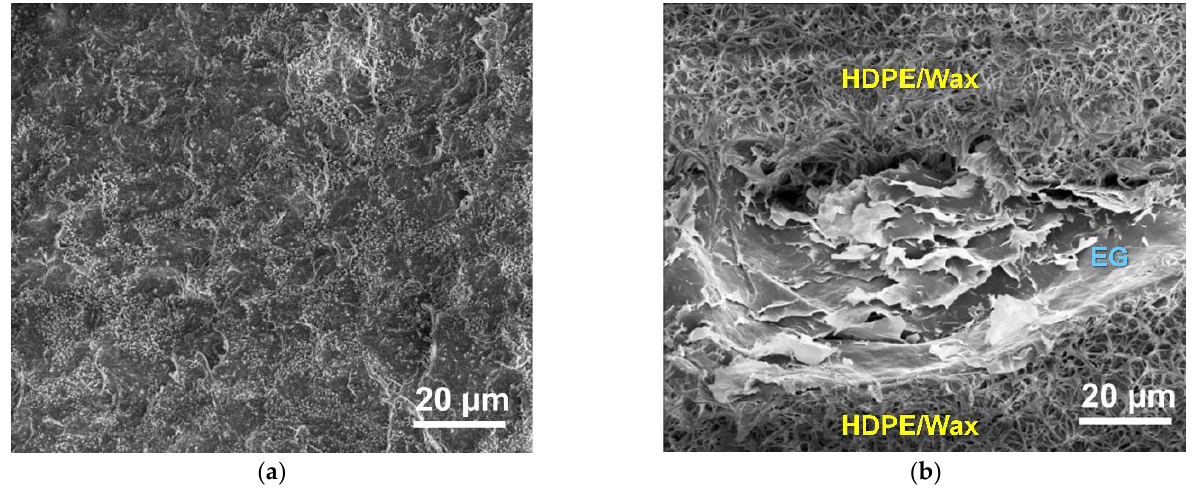
Figure 4. SEM images of SSPCMs: ( a ) 50/50 (HDPE/Wax); ( b ) 40/50/10 (HDPE/Wax/EG).